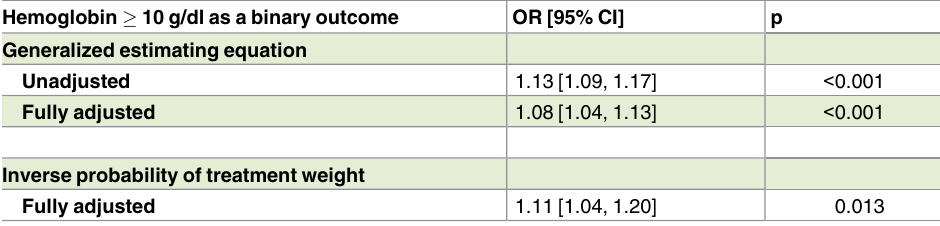
Table 2. Unadjusted and adjusted effects of each 6 additional months of cinacalcet therapy on the odds of achieving the treatment target (intention-to-treat